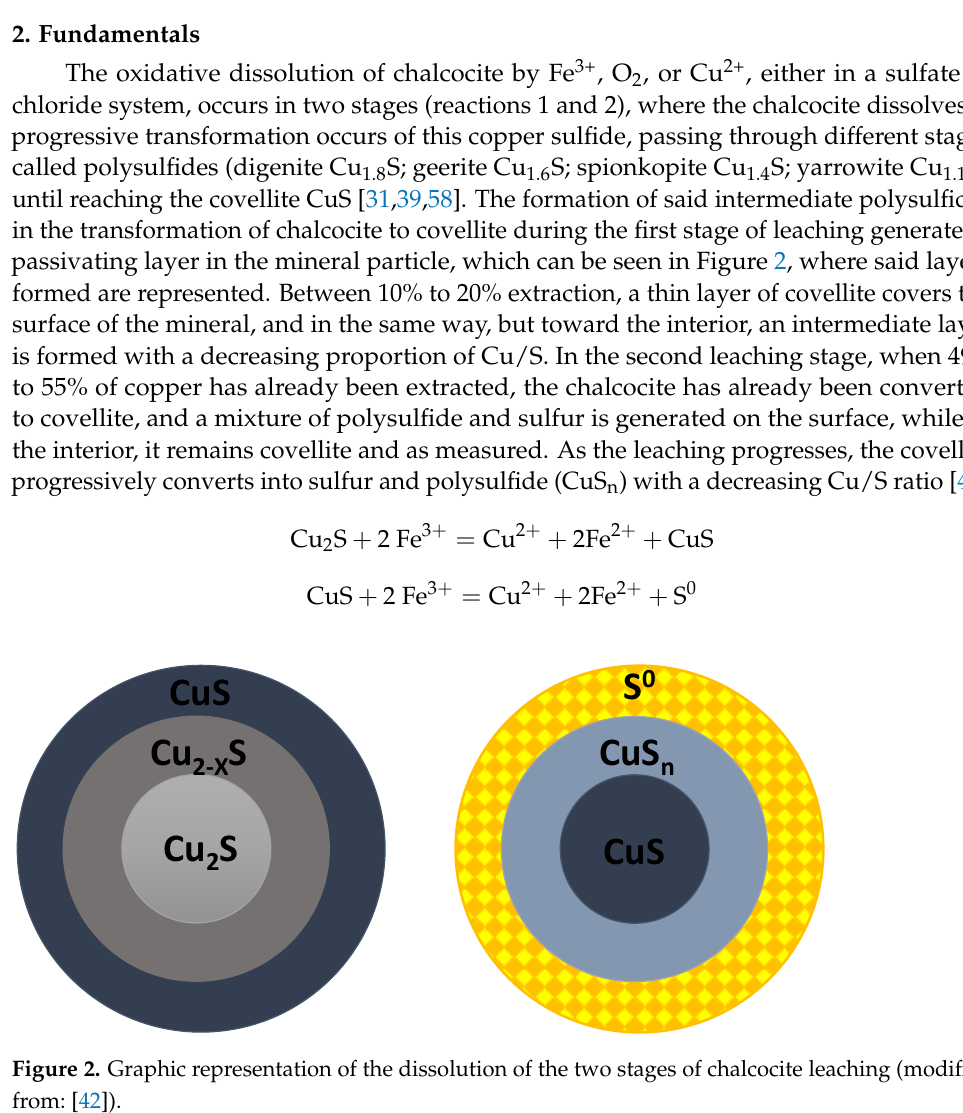
Figure 1. Extraction of copper from sulfide ores in a heap leach using H 2 SO 4 and chloride (modified from: [56]).